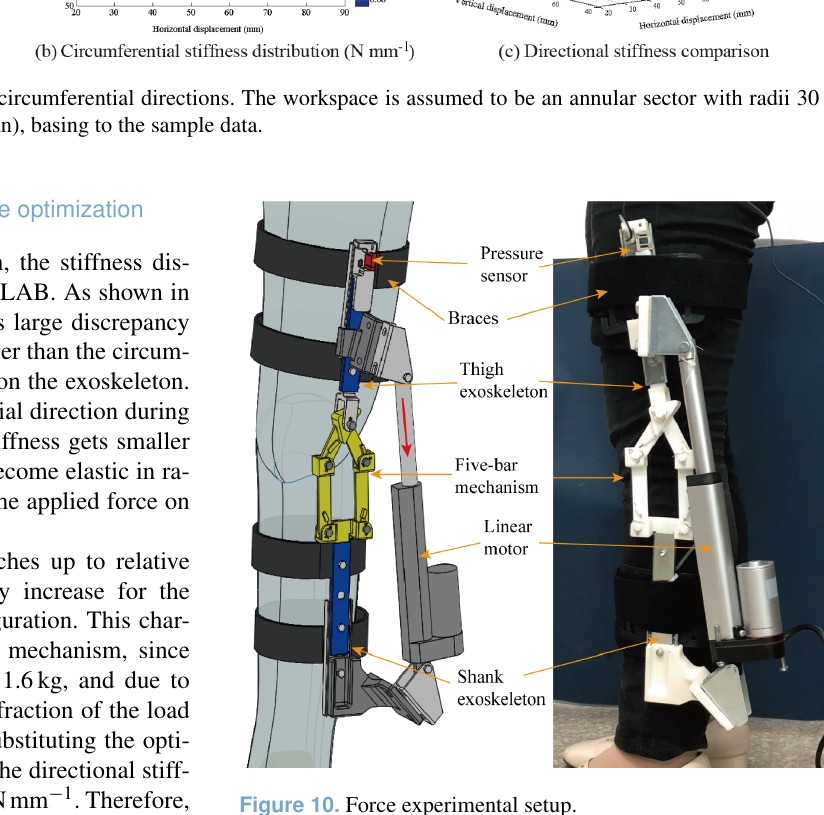
Figure 10. Force experimental